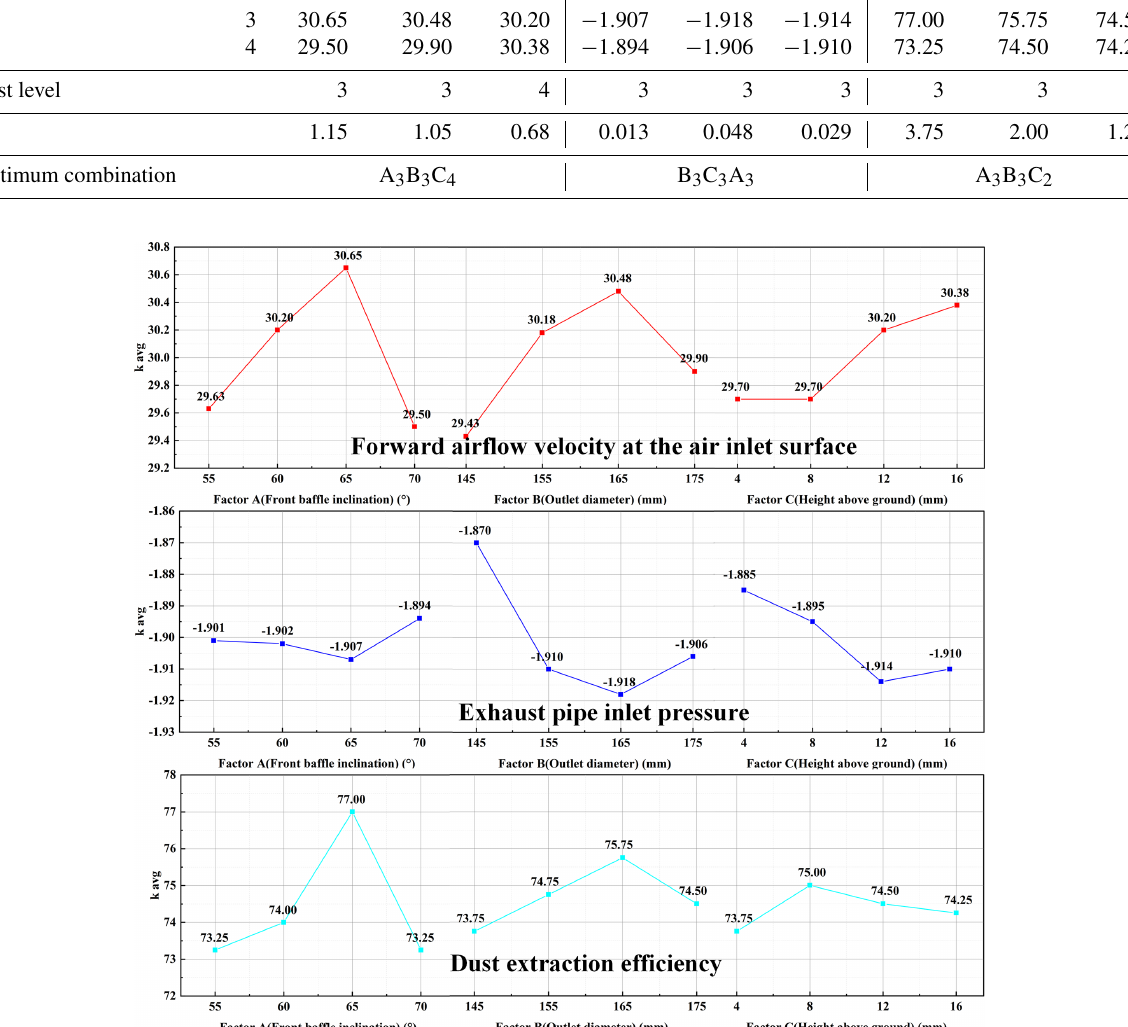
Figure 12. Plot of average values for each level of the factors.